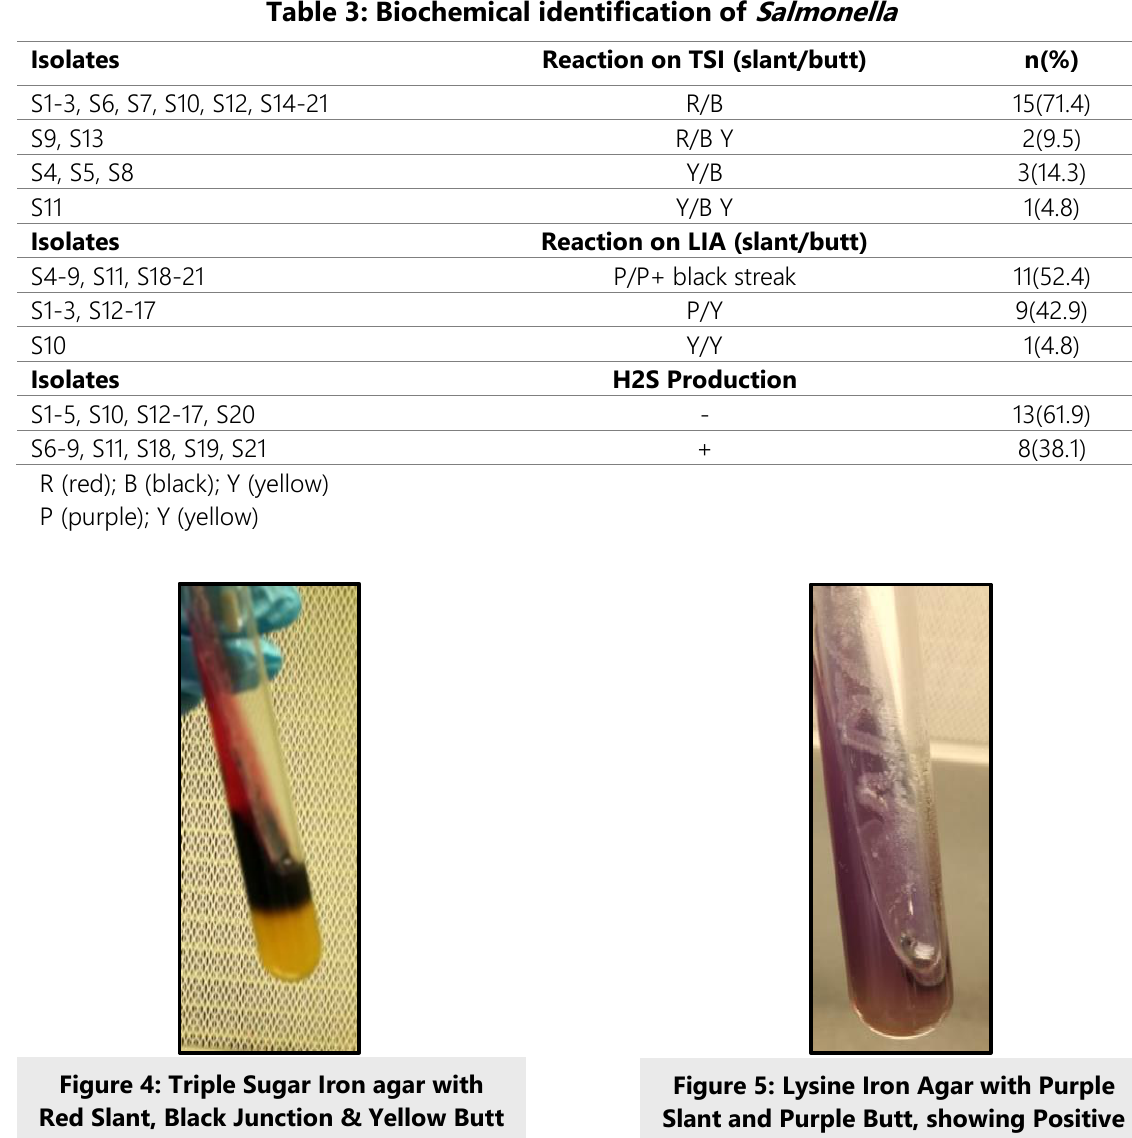
Figure 2: Enlarged Separated Colonies of Salmonella on XLD Agar